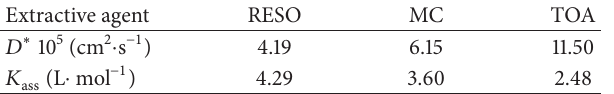
Table 3: Values of microscopic parameters ( 𝐷 ∗ and 𝐾 facilitated extraction of VO 2+ ions. Extractive agent RESO MC TOA